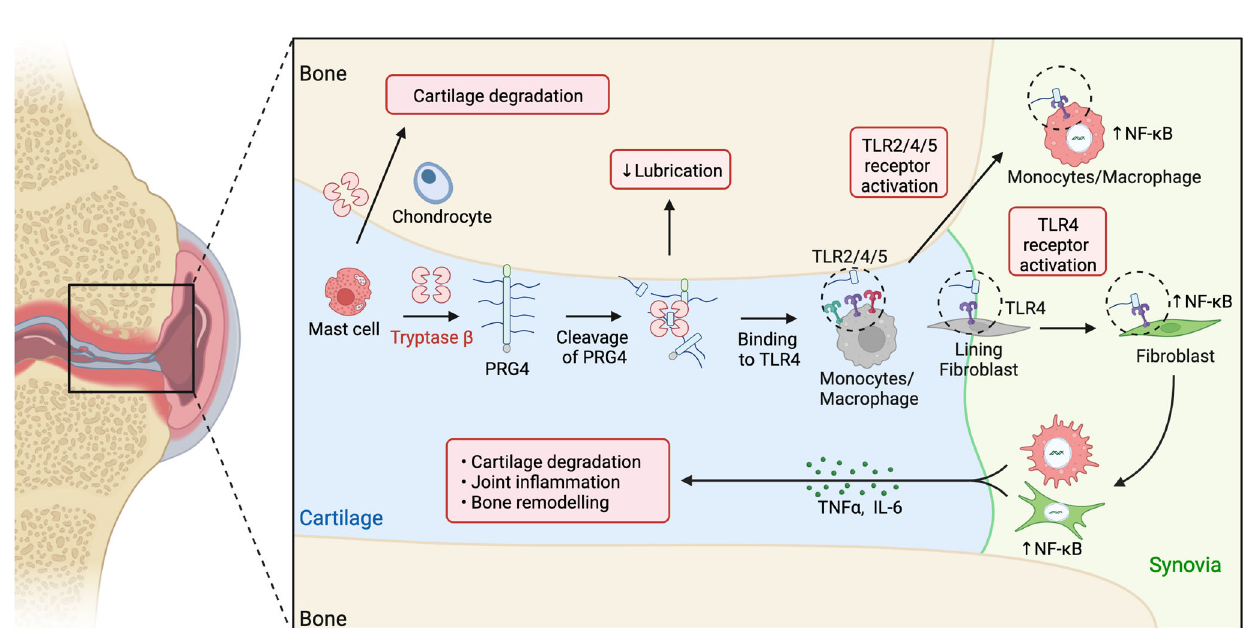
Fig.9|MechanismsofPRG4processingbyTryptase β . Work fl owschematicoftryptase β processingofPRG4resultinginTLRactivationandNF- κ Bactivationinhuman synovial fl uids in OA patients. Graphic created using BioRender.